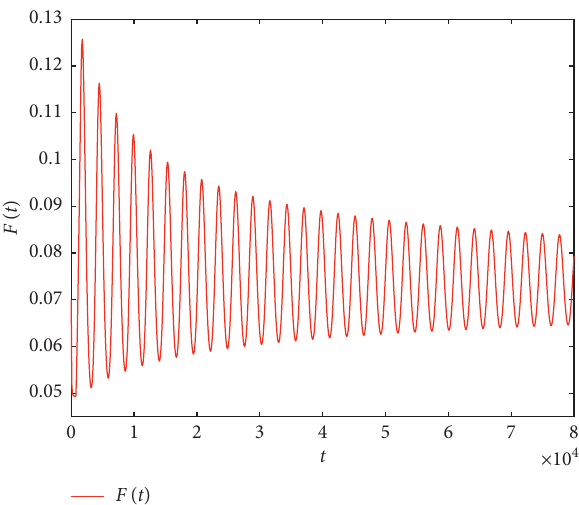
Figure 9: Time series solution of system (30) with ϕ � 0 . 90, � 728 . 403. τ � 740 > τ 0